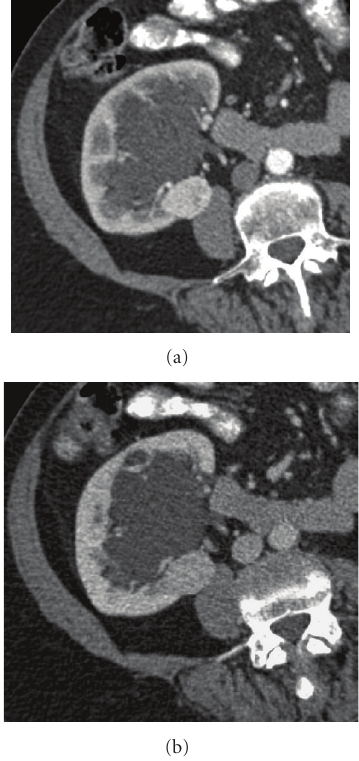
Figure 8: Small hyper vascular renal cell carcinoma. (a) Contrast- enhanced CT shows small renal mass that enhances early in corticomedullary phase. (b) Rapid washout in nephrographic